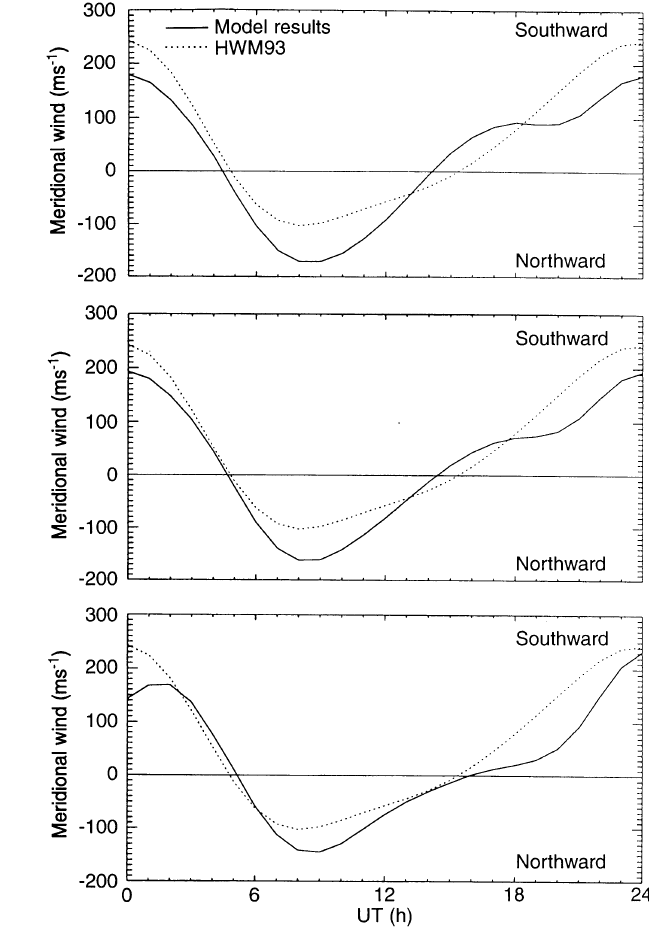
wind at the location of EISCAT (right panels) for the three cases of different FAC patterns: a maximum FACs in the 06 — 18-MLT, b 08 — 20-MLT and c 10 — 22-MLT meridional